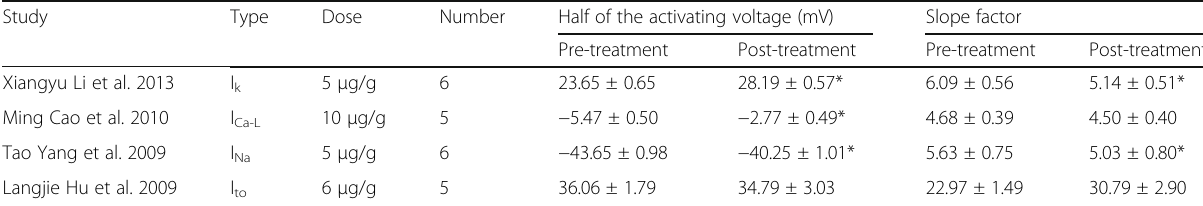
Table 4 The detailed information of the activation curve Study Type Dose Number Half of the activating voltage (mV) Slope factor Pre-treatment Post-treatment Pre-treatment